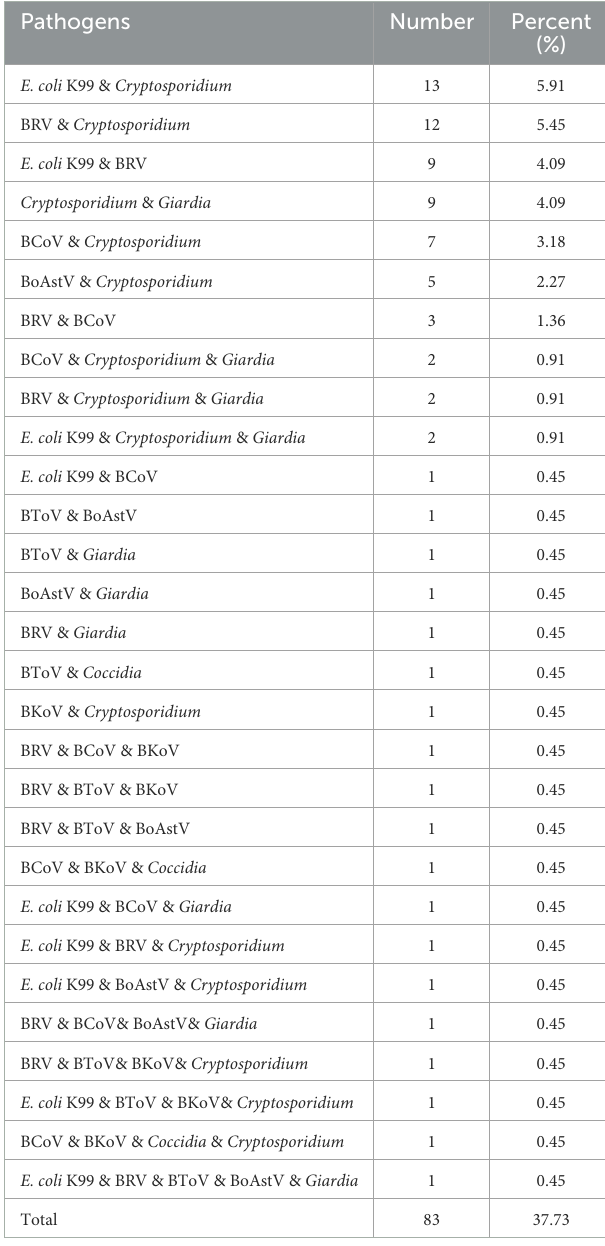
TABLE 5 The details of calf diarrhea mixed infection.